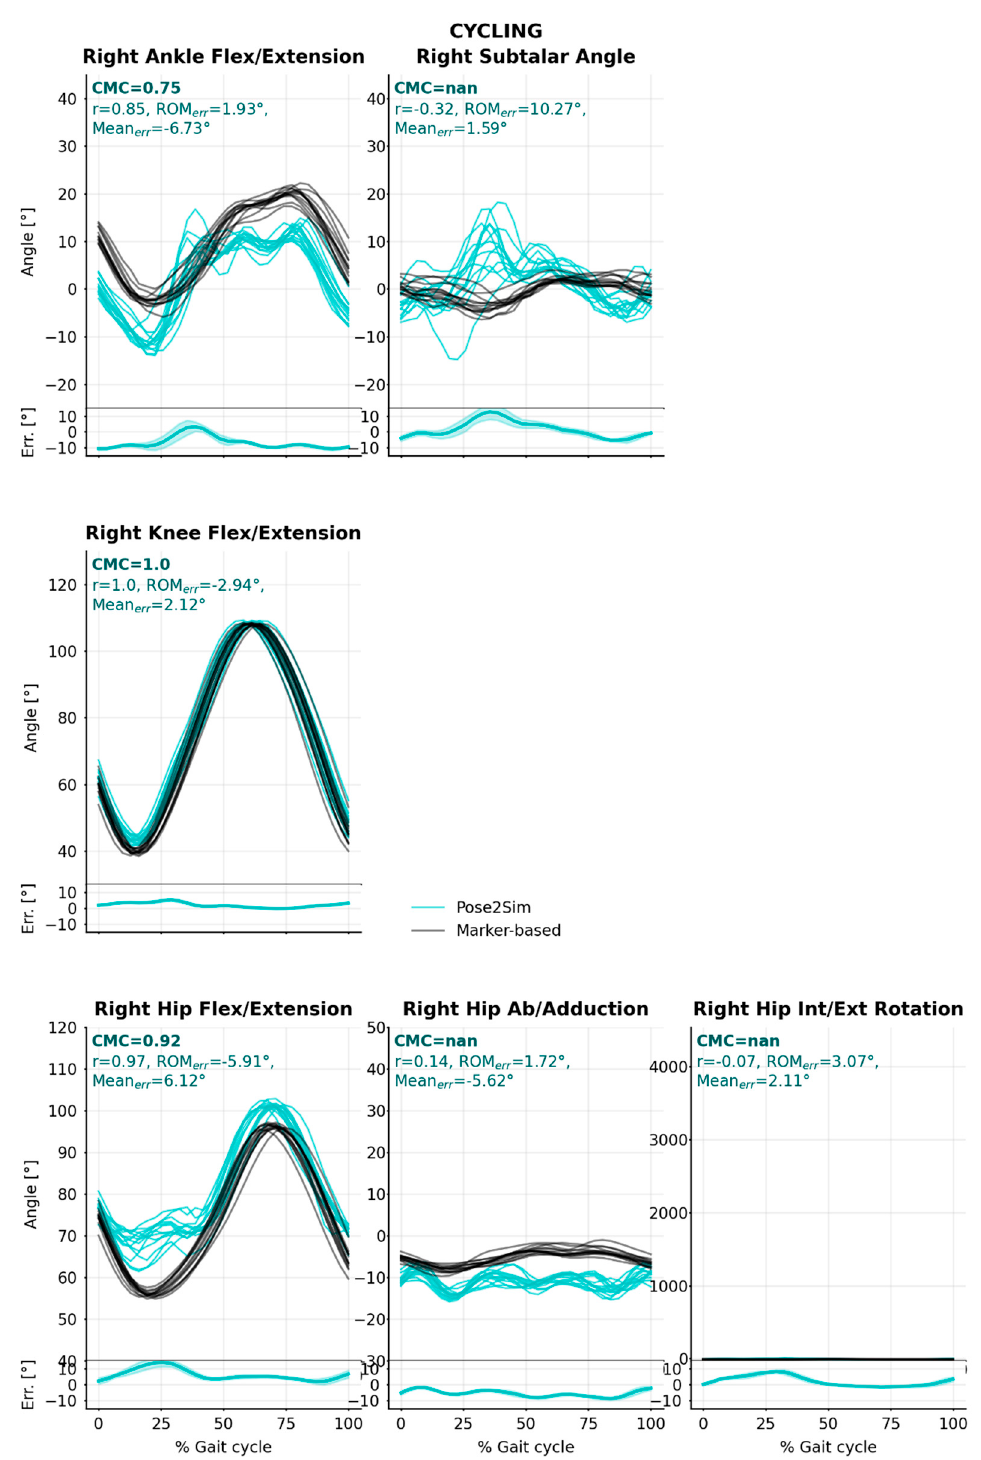
Figure A7. Pose2Sim (cyan) and marker-based (black) lower-body joint angles for the cycling task. Coefficient of multiple correlation (CMC) is indicated, and broken down into, respectively, Pearson’s coefficient (r) for correlation assessment, range of motion errors (ROM err ) for gain, and overall mean errors (Mean err ) for offset. Mean error and standard deviations are also represented at the bottom of the graphics.